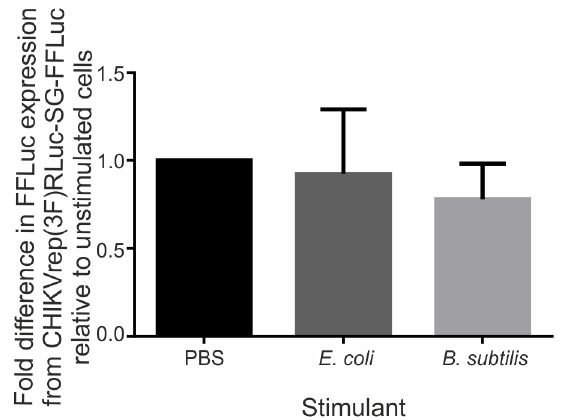
Figure 6. Effects of pathway stimulation on CHIKVRep(3F)RLuc- SG-FFLuc replication. Aag2 cells were pre-stimulated with heat inactivated bacteria, followed by transfection of CHIKVRep(3F)RLuc-SG- FFLuc replicon RNA. Replicon replication was assessed 12 h post pathway stimulation by FFLuc activity. PBS, PBS added to cells containing CHIKVRep(3F)RLuc-SG-FFLuc replicon; E. coli , heat inactivat- ed bacteria added to cells containing CHIKVRep(3F)RLuc-SG-FFLuc replicon; B. subtilis , heat inactivated bacteria added to cells containing CHIKVRep(3F)RLuc-SG-FFLuc replicon. The dark grey bar shows CHIKVRep(3F)RLuc-SG-FFLuc replication after JAK/STAT and IMD pathway stimulation with heat inactivated E. coli . Light grey bar shows CHIKVRep(3F)RLuc-SG-FFLuc replication after Toll pathway stimulation with heat inactivated B. subtilis . Replicon replication after bacterial stimulation is calculated relative to replicon replication after stimulation with PBS (black bar). The graph represents the mean of three independent experiments performed in triplicate and error bars represent the standard error of mean.